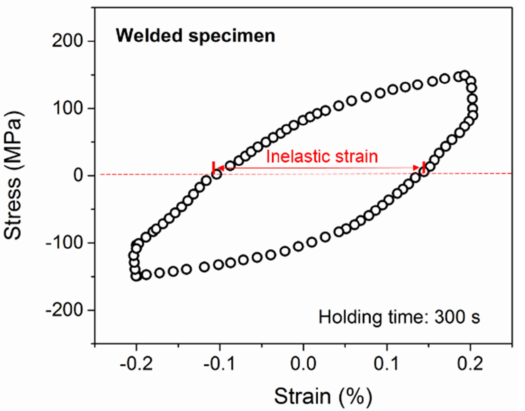
Figure 6. The representative strain-stress hysteresis loop of the welded specimen with a holding time of 300 s.